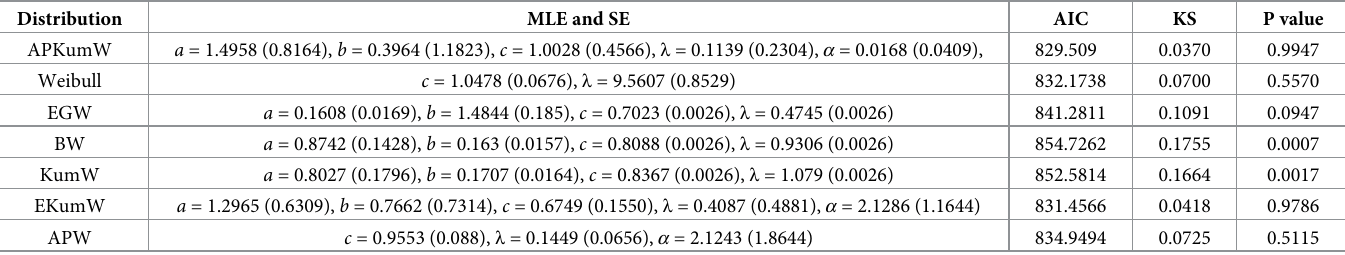
Table 7. MLEs, (SEs) for the parameters and associated goodness of fit statistics for the bladder cancer II data.